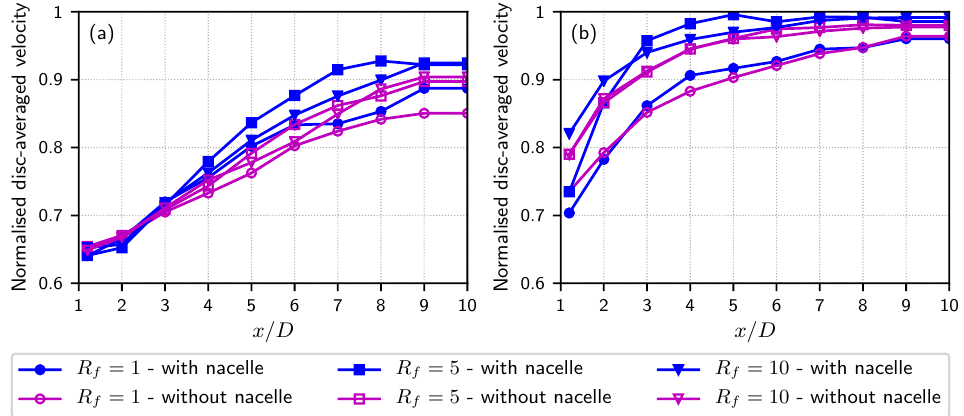
Figure 7. Comparison of the numerical disc-averaged velocities obtained for three filling ratios R f and two turbulence intensities (TSR = 3.67, λ = 4.5 m, σ = 0%). ( a ) I ∞ = 1.5%. ( b ) I ∞ =